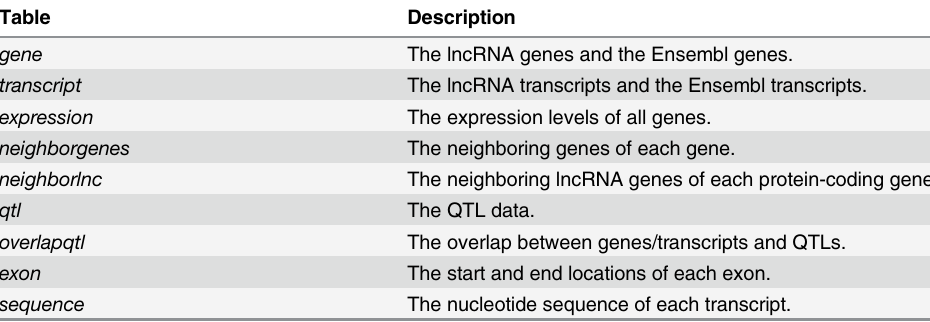
Table 2. Description of MySQL database tables. Table Description gene The lncRNA genes and the Ensembl genes. transcript The lncRNA transcripts and the Ensembl transcripts. expression The expression levels of all genes. neighborgenes The neighboring genes of each gene. neighborlnc The neighboring lncRNA genes of each protein-coding gene. qtl The QTL data. overlapqtl The overlap between genes/transcripts and QTLs. exon The start and end locations of each exon. sequence The nucleotide sequence of each